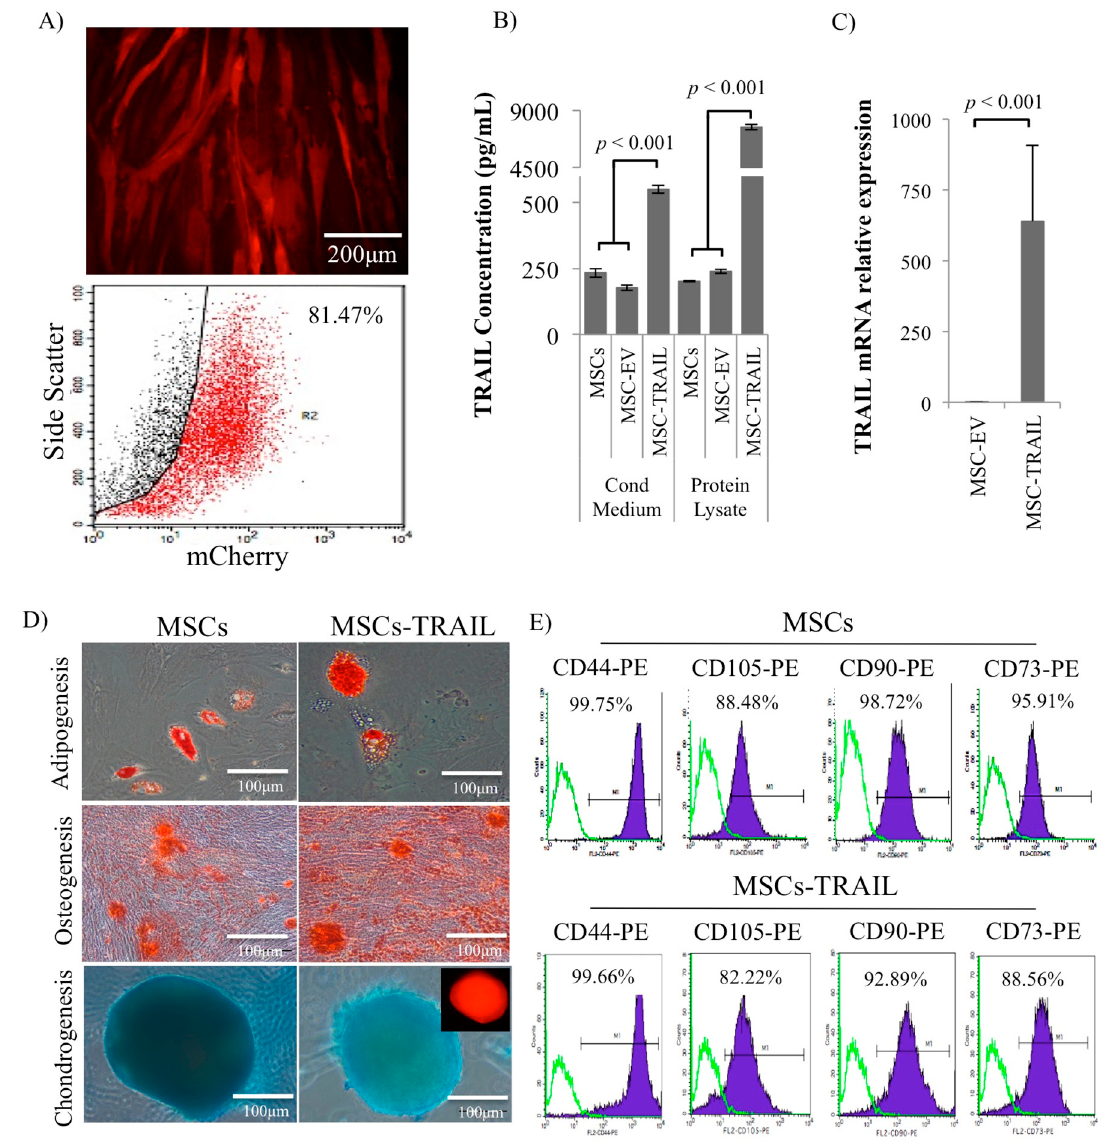
Figure 1. Verified mesenchymal stem cell expressing tumour necrosis factor (TNF)-related apoptosis inducing ligand (MSC-TRAIL) maintained its multipotent characteristics. ( A ) Representative microscopy images and flow cytometry analysis of mCherry in MSCs transduced with TRAIL-encoding lentivirus (MSC-TRAIL). ( B ) Analysis of TRAIL concentration by ELISA in both conditioned medium and protein lysate of MSCs (MSCs, MSC-EV (empty vector), and MSC-TRAIL). ( C ) Messenger RNA (mRNA) expression of TRAIL in transduced MSCs by qRT-PCR. ( D ) MSC-TRAIL and MSC differentiation: adipogenesis (Oil-Red O), osteogenesis (Alizarin Red), and chondrogenesis (Alcian Blue)/fluorescence. ( E ) MSC surface markers, cluster of differentiation (CD44, CD90, CD105, and CD73) analysis from MSC-TRAIL and MSCs by flow cytometry ( p < 0.001; t -test).